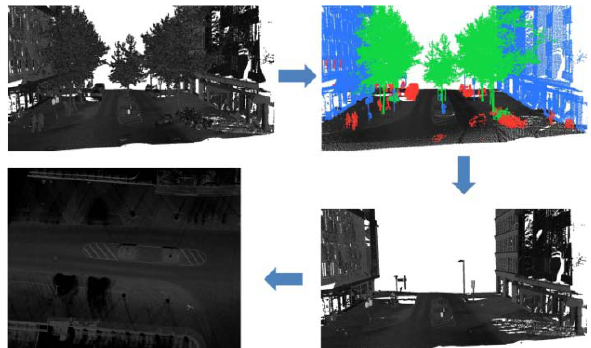
Figure 1. Image generation workflow. Dynamic objects like trees, pedestrians and cars are detected and removed. The reference images are generated using the filtered point